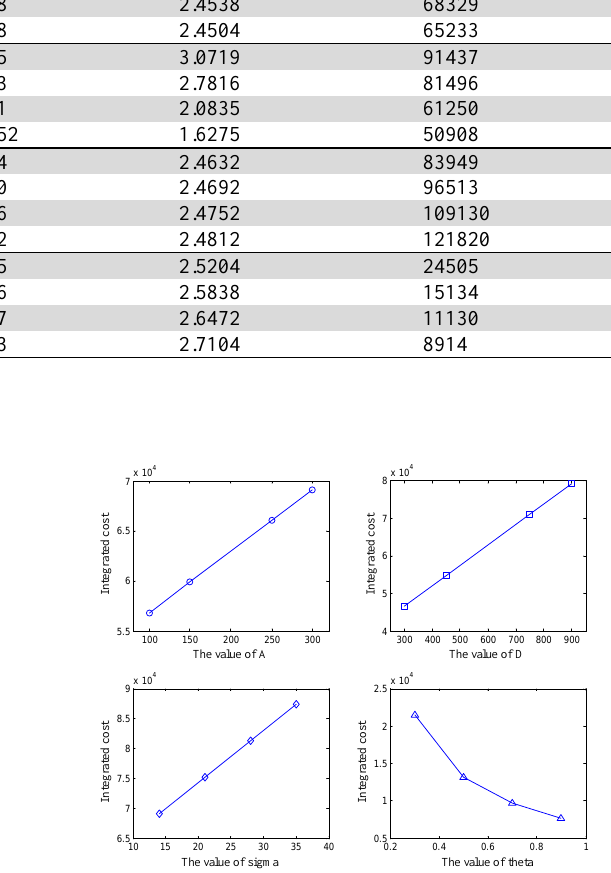
Fig. 3. Graphical representation of sensitivity analysis for numerical example